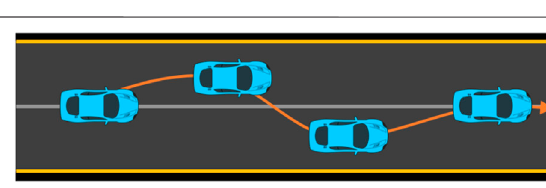
FIGURE 9 | Possible driving results around the intention of going straight.